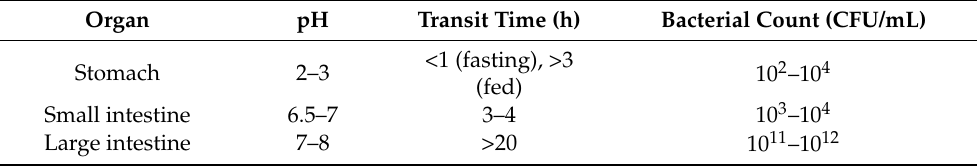
Table 2. Physiological Properties of the Gastrointestinal Tract * Organ